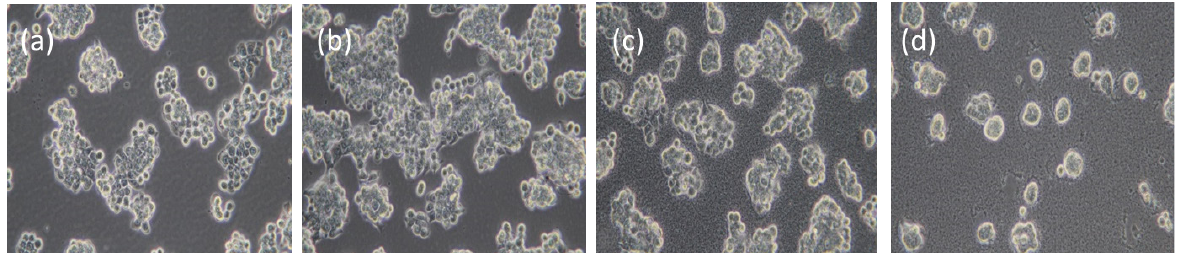
Figure 9. Bright field images of HT-29 cells with or without treatment of IBN-4-HRP and IAA: ( a ) HT-29 cells without treatment; ( b ) treatment with IAA (1.6 mM); ( c ) treatment with IBN-4-HRP alone; and ( d ) treatment with IBN-4-HRP and IAA (1.6 mM).